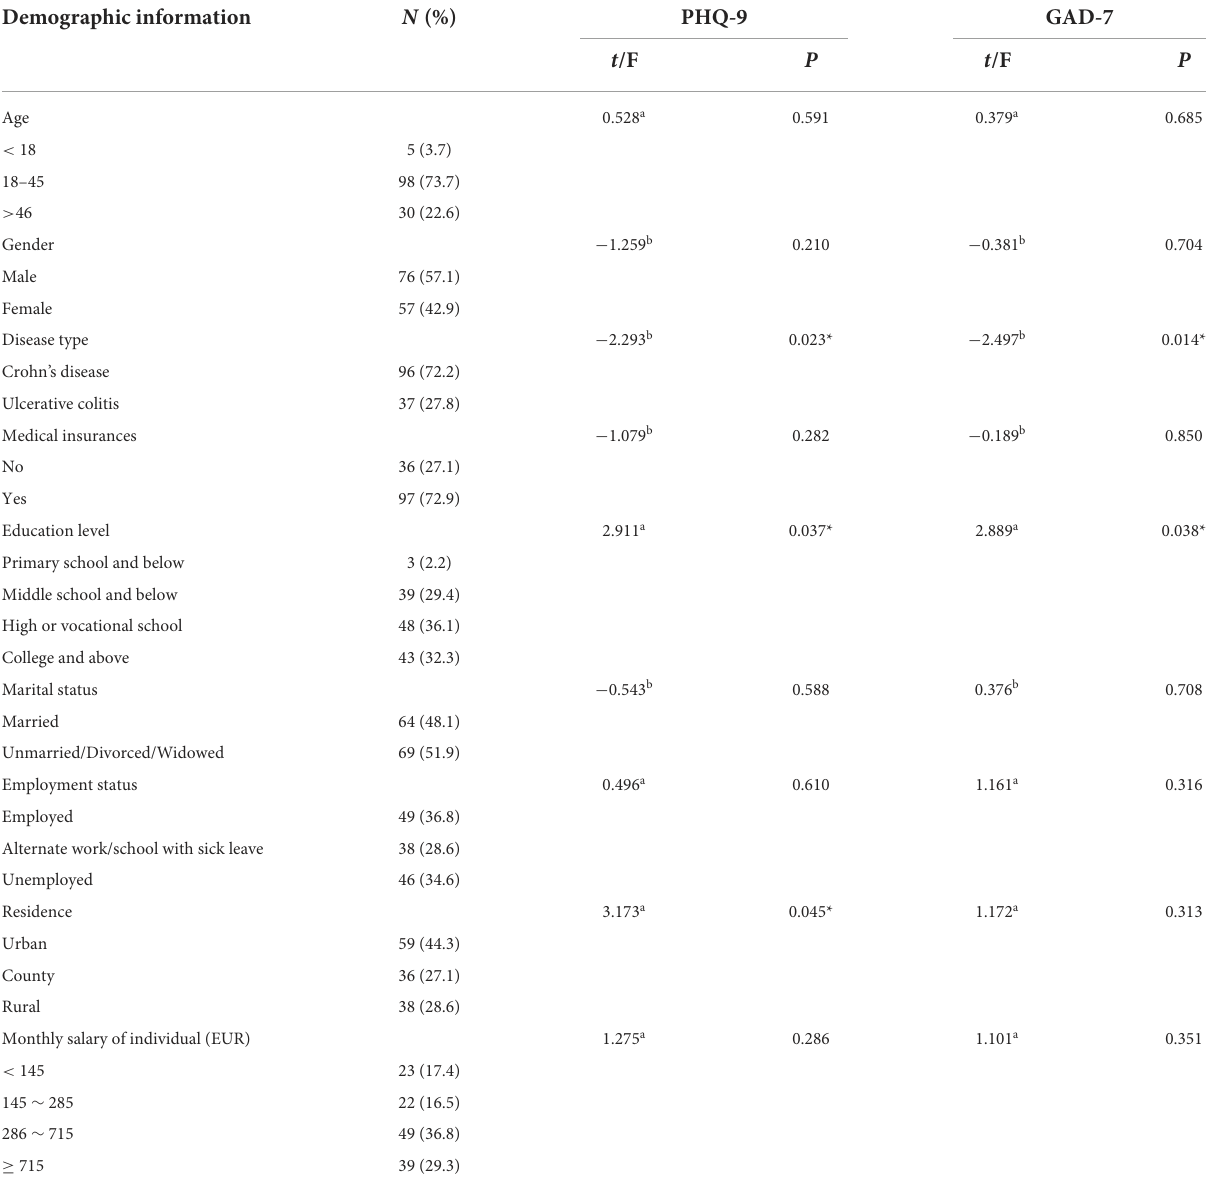
TABLE 1 Mental health status by demographic